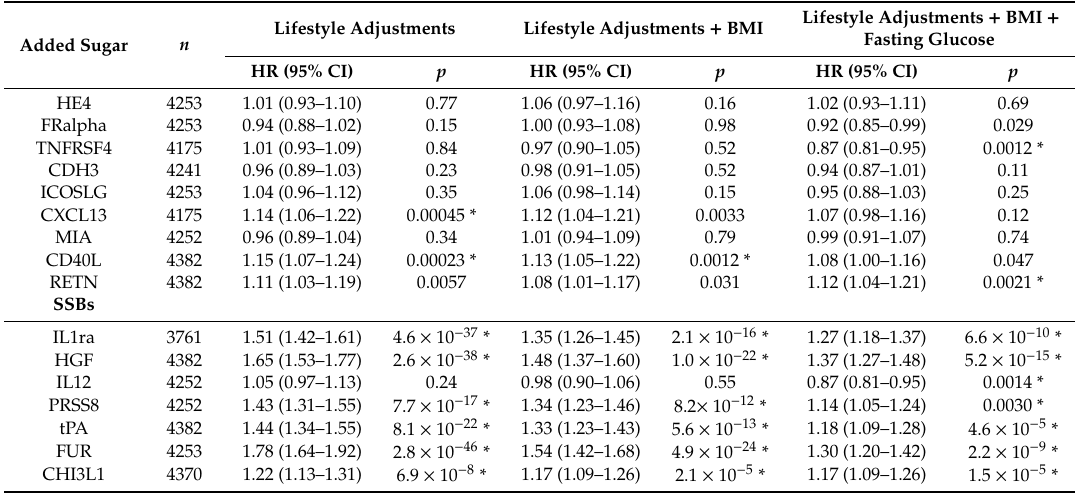
Table 4. Associations with T2D incidence for proteins internally replicated to associate with added sugar intake and SSB